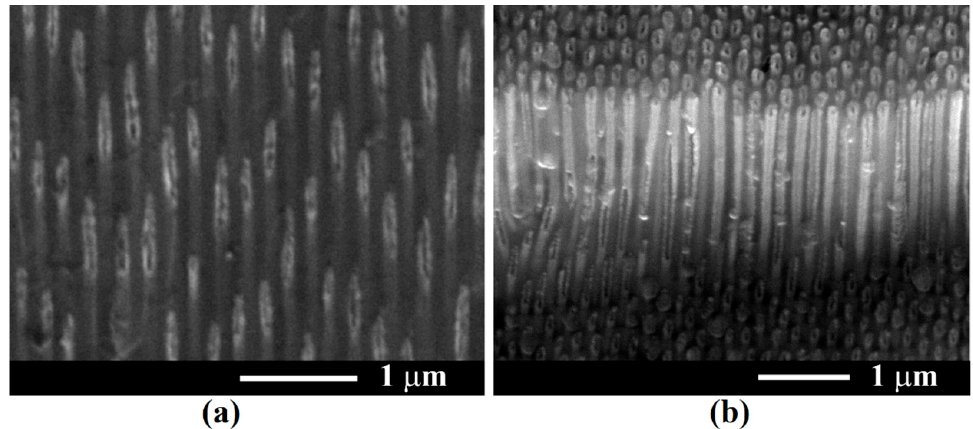
Figure 4. SEM images in cross-section, of Pt nanotubes in semiconductor InP envelope after electrochemical deposition with electroplating parameters of U = − 16 V, t on = 100 μ s, t off = 1 s, at different durations of electroplating: ( a ) 1 h; and ( b ) 2.5 h.